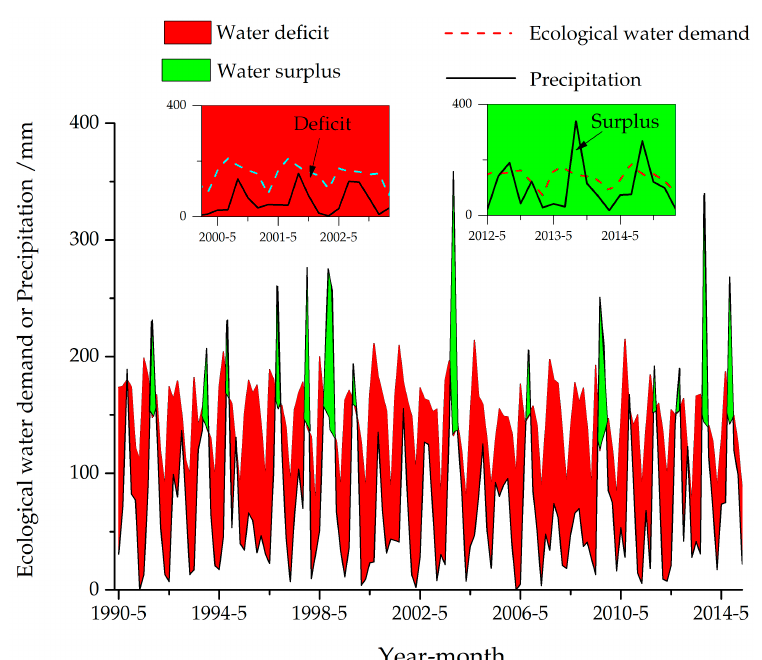
Figure 3. The map of Wuyur River Basin.